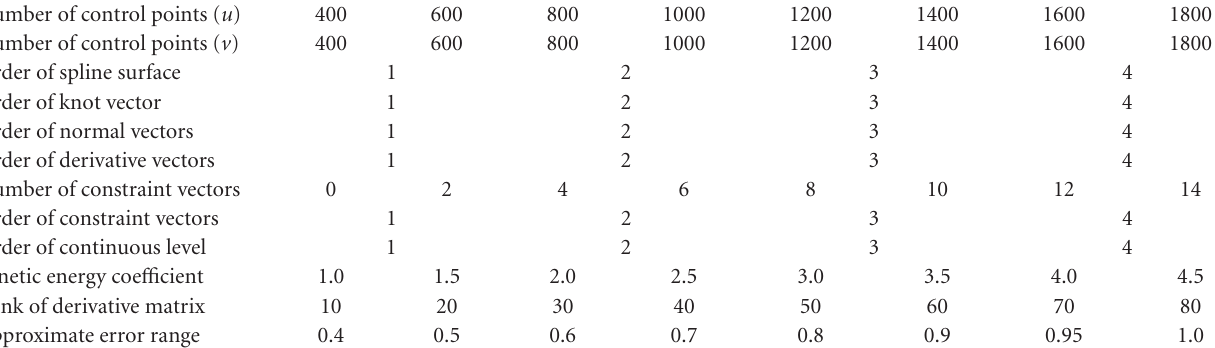
Table 2: External experimental parameters for di ff erent surface modeling methods.